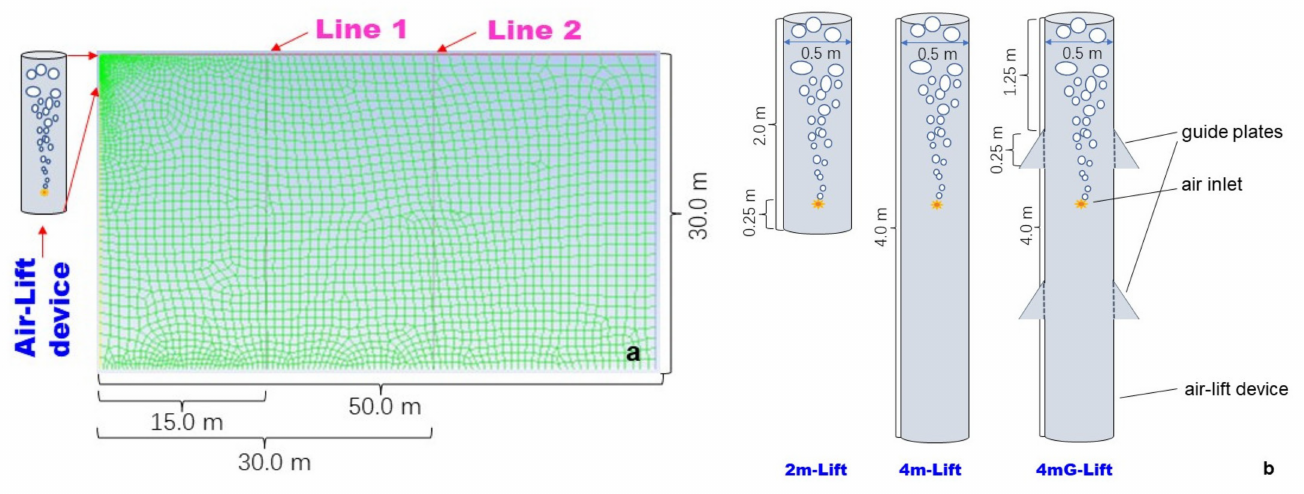
Figure 1. Schematic of the location of airlift device in lake water ( a ) and different configuration of the device ( b